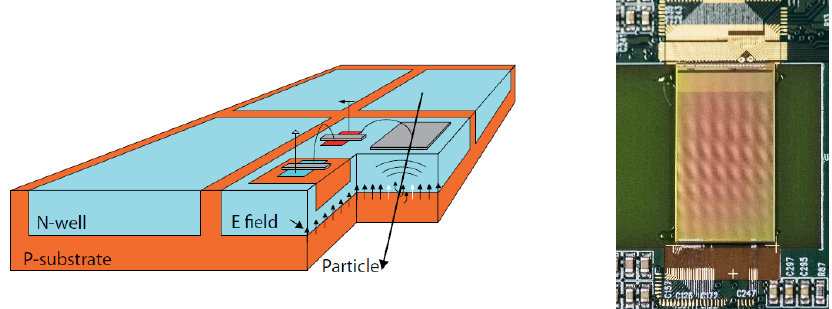
Figure 6: Schematic of a pixel sensor in HV-MAPS technology [ 6,7 ] (left) and photo of the MuPix8 sensor prototype with an active area of 19 × 10 mm 2 (right).